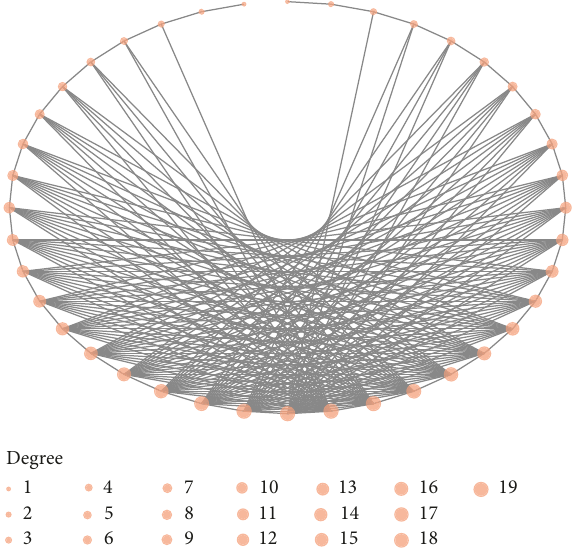
Figure 3: Degree sequence network.